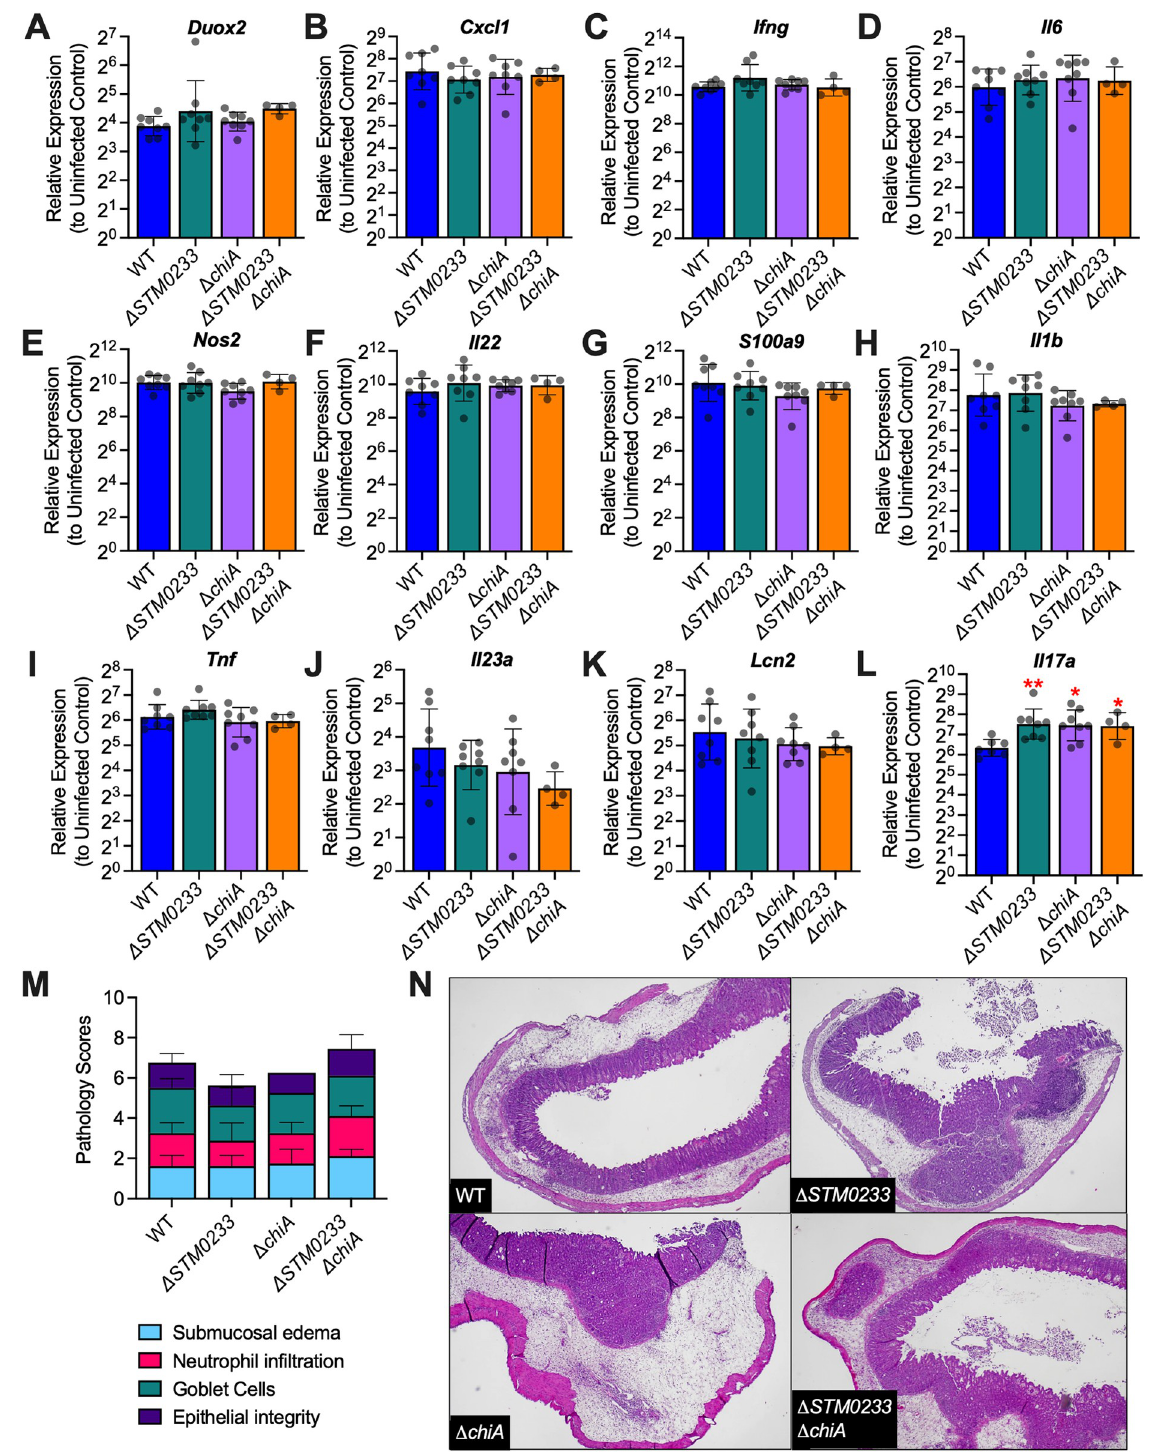
Fig 4. S . Typhimurium chitinases do not modulate the innate immune response in vivo . (A-L) mRNA expression of innate immune genes extracted from cecal tissue of S . Typhimurium infected mice 48 hpi. Expression is normalized to the housekeeping gene actb as well as gene expression in uninfected mice. WT n = 8, Δ STM0233 n = 8, Δ chiA n = 8, Δ STM0233 Δ chiA n = 4. Bars represent geometric mean ± geometric SD. (M) Histopathological scoring of cecal tissue from S . Typhimurium infected mice 48 hpi. WT n = 8, Δ STM0233 n = 8, Δ chiA n = 8, Δ STM0233 Δ chiA n = 9. Tissues were scored for submucosal edema, neutrophil infiltration, goblet cells, and epithelial integrity. Bars